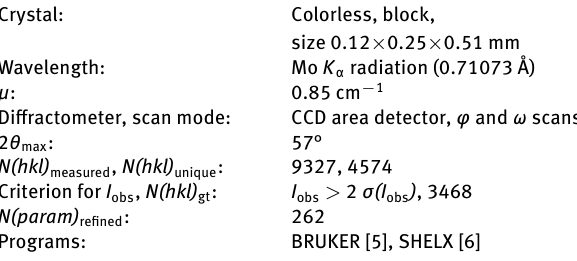
Table 1: Data collection and handling.